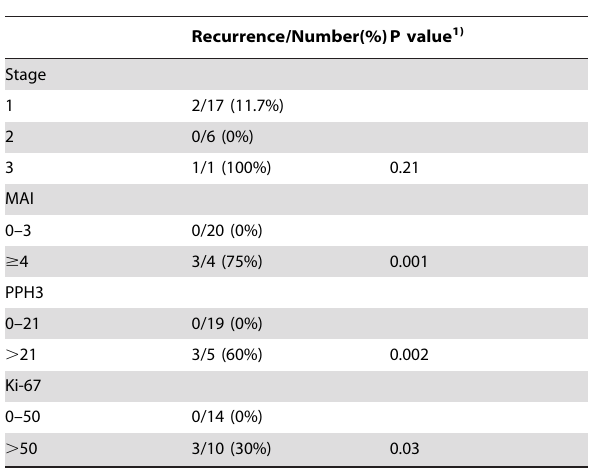
Table 1. Clinicopathologic data from the patients.